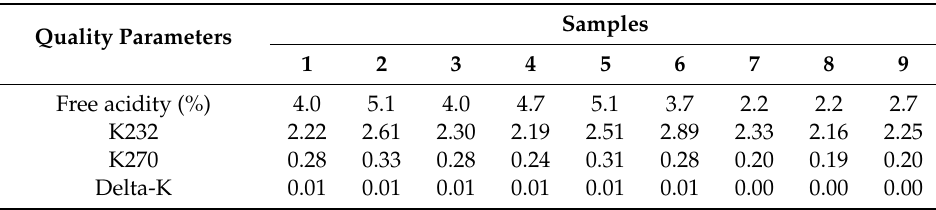
Table 1. Quality parameters of selected lampante